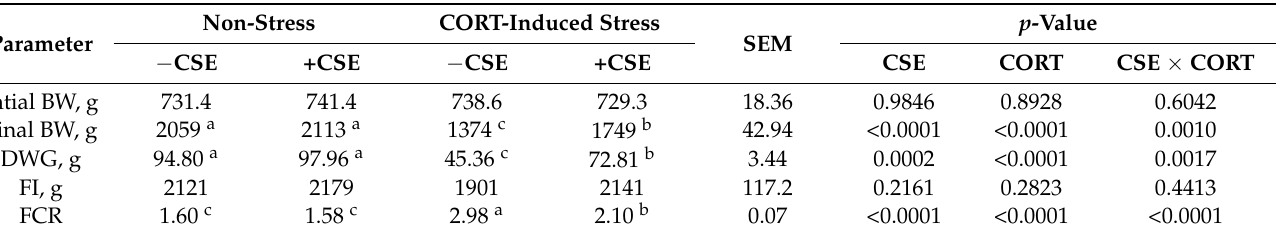
Table 3. Production performance parameters of broiler chickens subjected to corticosterone induced- oxidative stress (CORT) and fed corn silk extract